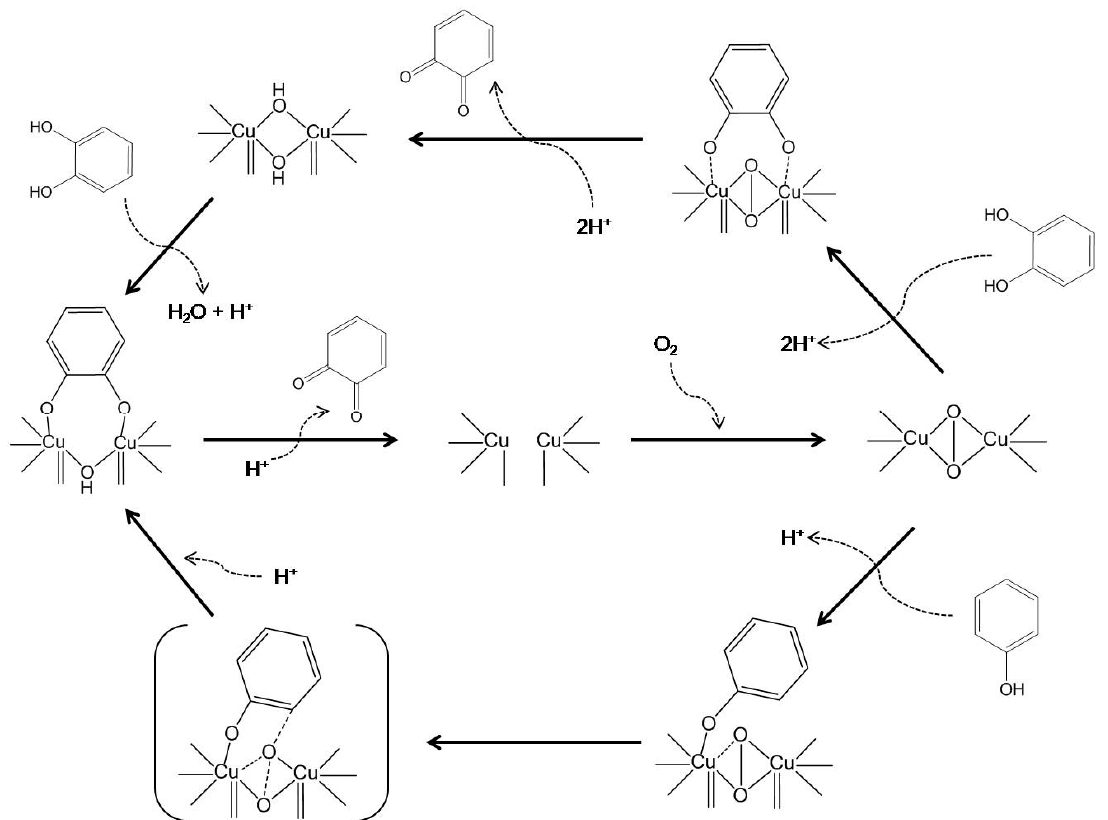
Figure 4. Detailed mechanism for polyphenol oxidase activity.